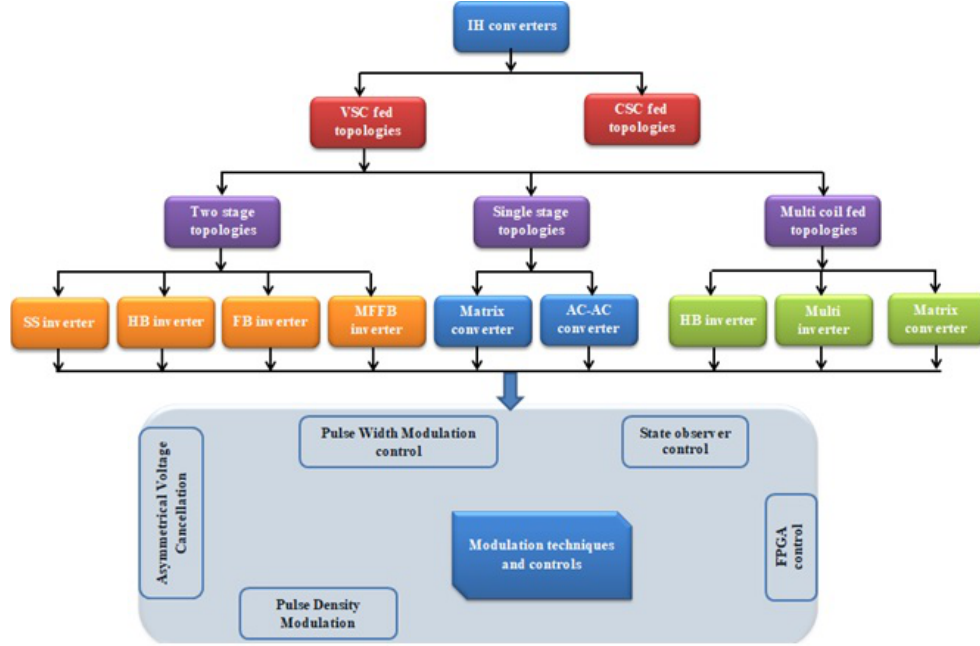
Figure 2. General structure of power converter topologies and modulations applied to IH